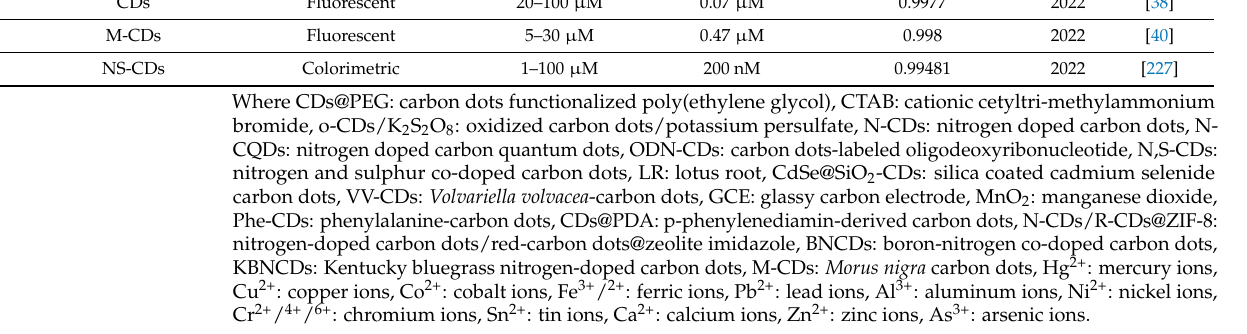
Table 11. Summary of the developed optical sensors for phenol